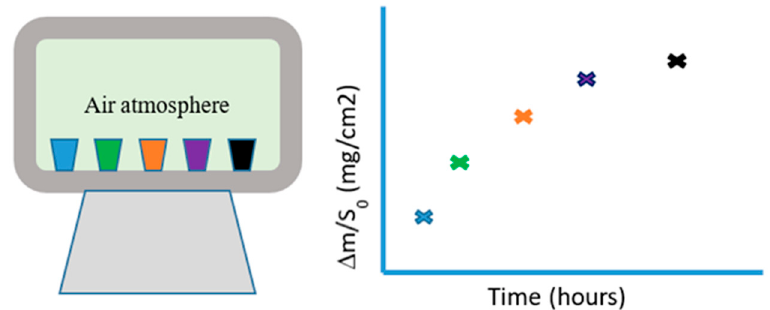
Figure 2. Experimental set up for corrosion tests ( left ) including the data used for the weight change gravimetric curve ( right ).